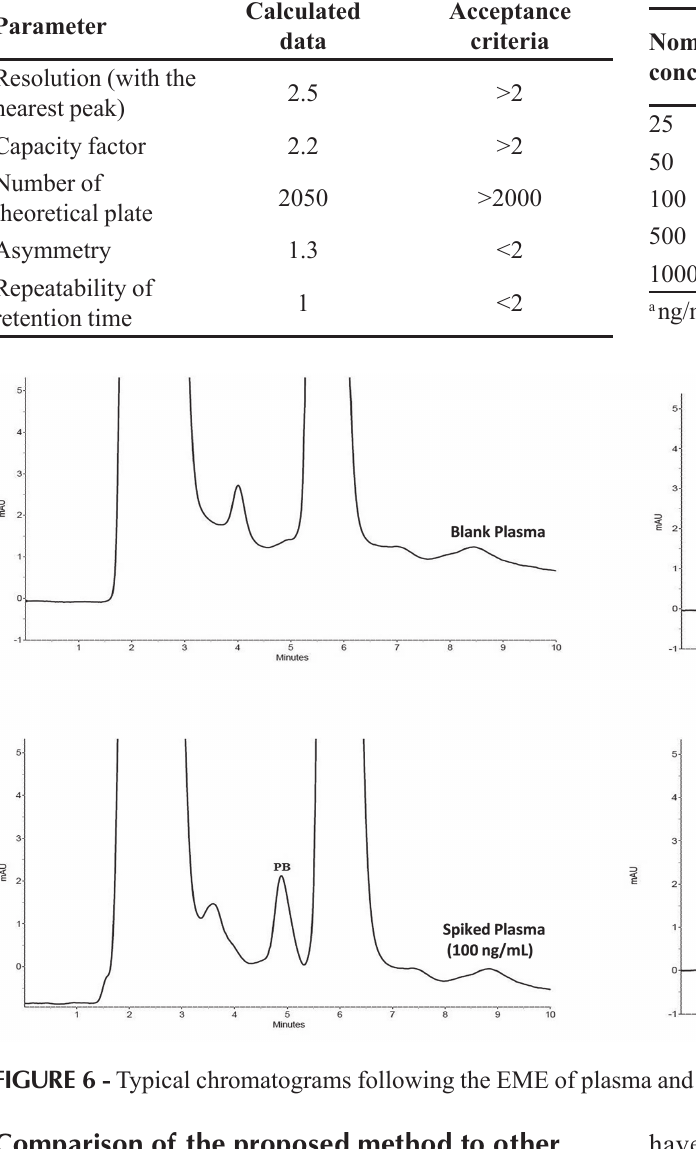
TABLE II - HPLC System suitability test